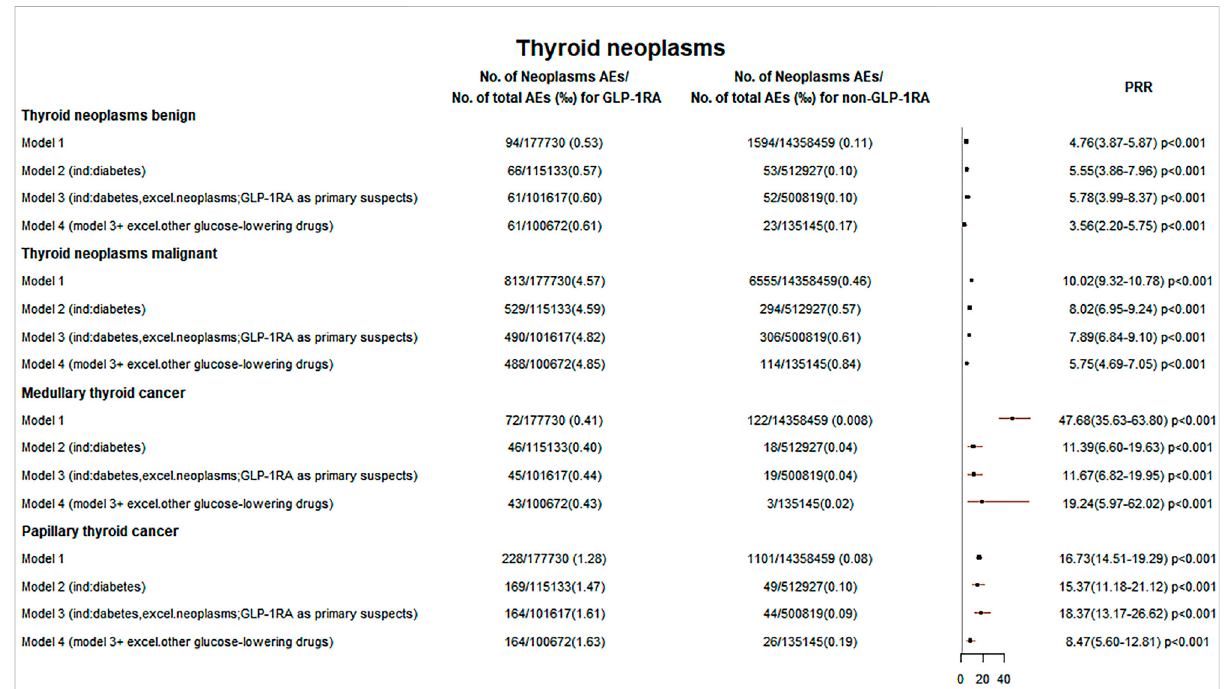
FIGURE 2 Thyroid neoplasm reporting rates. The reporting rates of GLP-1RA-associated neoplasms were compared with different comparators in four models: 1) other drugs excluding GLP-1RA (non-GLP-1RA) without indication restrictions; 2) non-GLP-1RA when diabetes as an indication; 3) non- GLP-1RA when the indication is limited to diabetes while excluding all tumors, and all cases with GLP-1RA as the “ primary suspect ” drug; and 4) all cases combining other glucose-lowering drugs were excluded on the basis of model 3 for